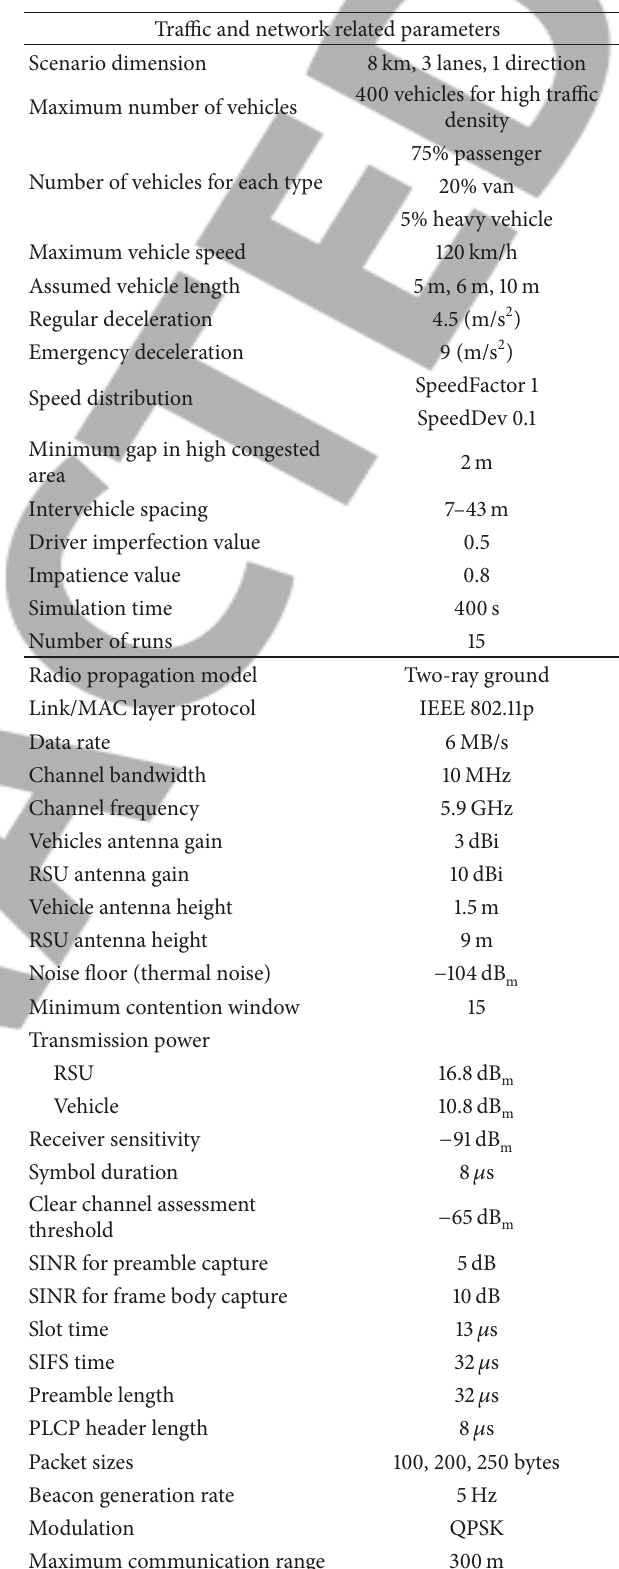
Table 5: Simulation parameters